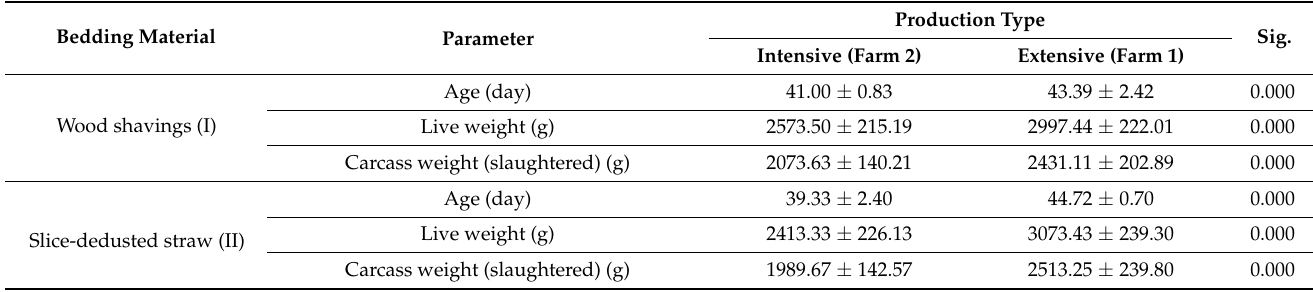
Table 2. Growth characteristics of broiler